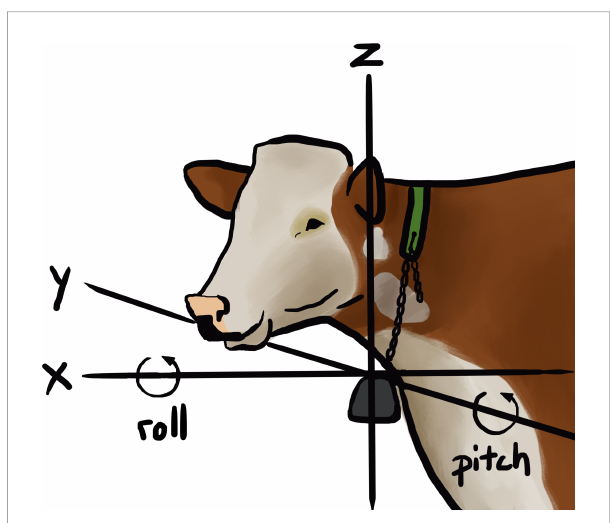
FIGURE 1 Position of the GPS collar below the cows ’ neck. Black lines indicate the direction of the three axes (X, Y, Z) and arrows indicate on which axis the roll and pitch were calculated. Art by Saskia H.